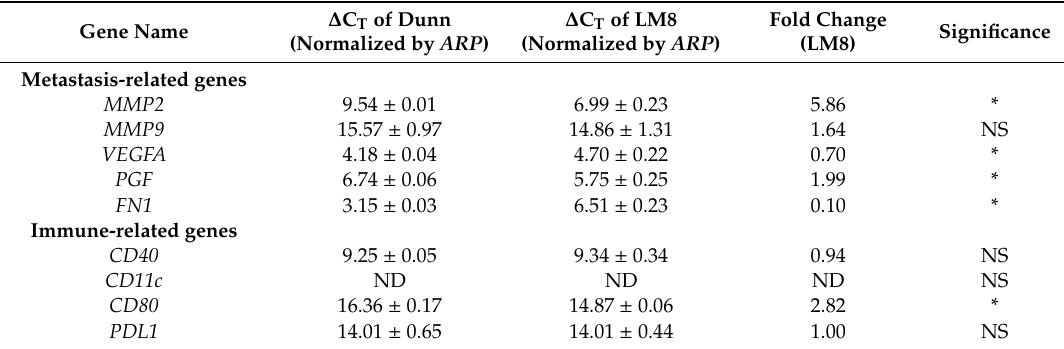
Table A3. Gene expression of in vitro cultured cells by qRT-PCR.